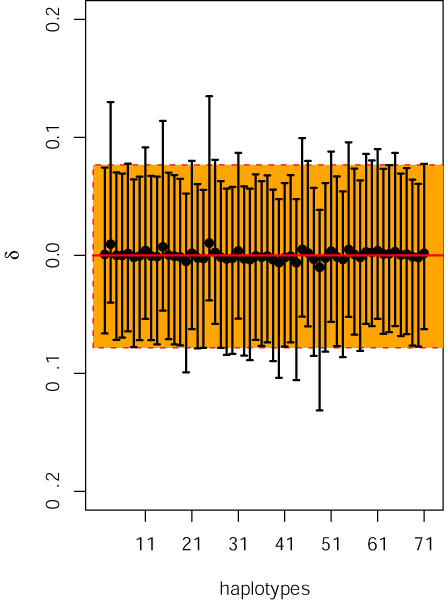
Danacaa, replicate 2, D03S0126–D03S0127. Estimated posterior means and 95% confidence intervals for the effects of individual haplotypes for both CAR (56 individual haplotype effects) and Potts models (a single cluster effect, represented by the orange area).